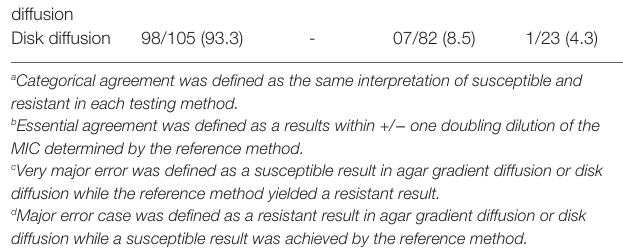
Supplementary Table S1 ). The subgroup of OXA-48-producers (8/18 (44.4%) isolates mecillinam susceptible) consisted of nine